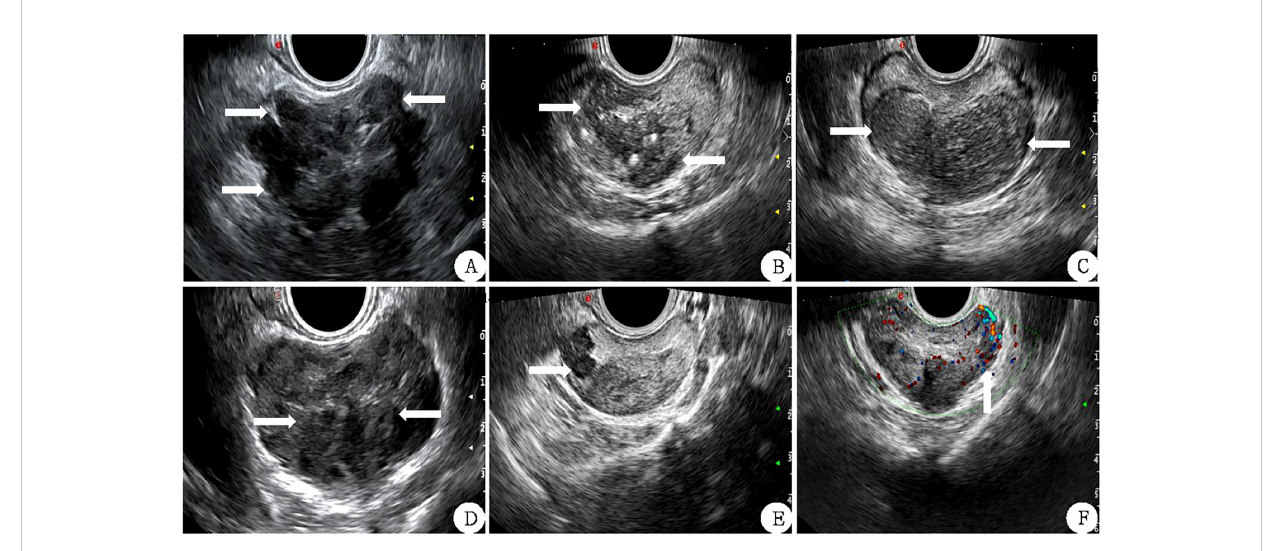
FIGURE 2 Correlation features of prostate 2D ultrasound image scores (white arrow) (A) The lateral lobe capsule is not smooth and protrudes outwards. (B) : the echo of the inner and outer glands is uniform and the boundary is not clear. (C) left and right lobes are not symmetrical. (D) The boundary between the inner and outer glands is unclear. (E) Hypoechoic nodules can be seen in the right external gland. (F) There is abundant blood fl ow in the left external gland nodule.